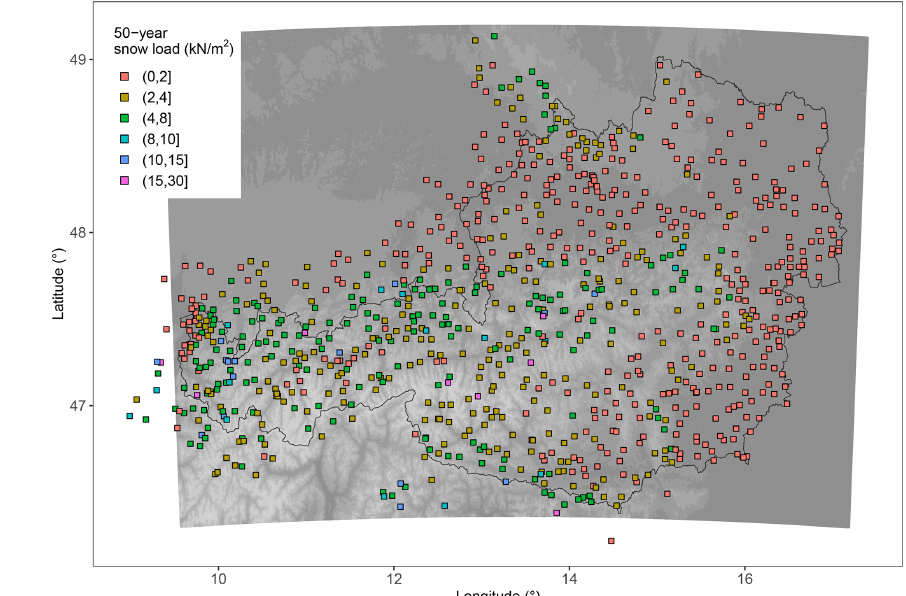
Figure 3. Values of 50-year snow load return from (cid:49) SNOW -modeled yearly maxima locally fitted to a GEV distribution for all 897 stations. Elevation is given in grayscale from 100m (dark) to 3800m